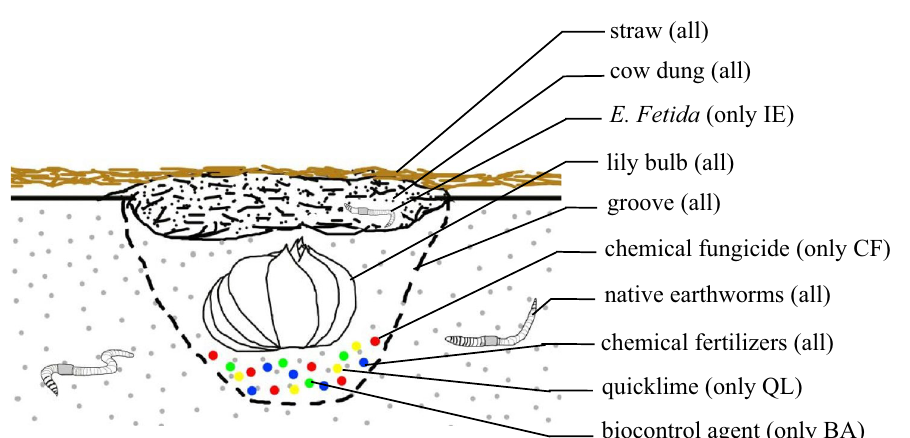
Figure 9. Profile of the lily after planting. The steps for lily planting were as follows. First, every plot was ploughed and ridged. Second, maked grooves in the ridges. Third, applied chemical fertilizer (all the treatments), quicklime (only QL), chemical fungicide (only CF), and biocontrol agent (only BA) at the bottom of the groove, and covered with a small amount of soil. Fourth, putted the lily bulbs in the groove. Fifth, covered the lily bulbs with soil. Sixth, sprinkled cow dung on the lily bulbs. Seventh, inoculated earthworms into cow dung (only IE) and covered the ridges with straw. QL quicklime, CF chemical fungicide, IE inoculation with earthworms, BA biocontrol